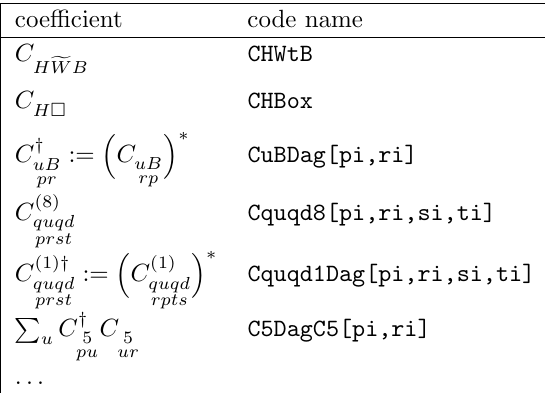
Table 6 . Code conventions for (cid:13)avor indices.